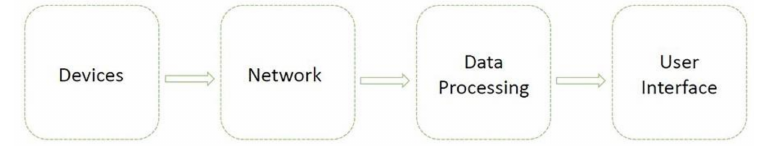
Figure 3. Block diagram of the IoT